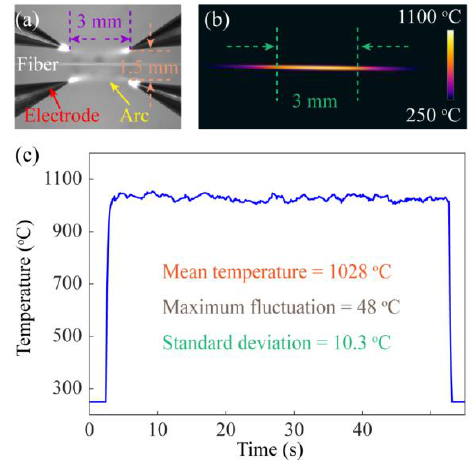
Figure 7. ( a ) The enlarged view of the electrodes. ( b ) Temperature distribution on the surface of the fiber during the arc discharge. ( c ) The variation of the highest temperature on the fiber surface with time.